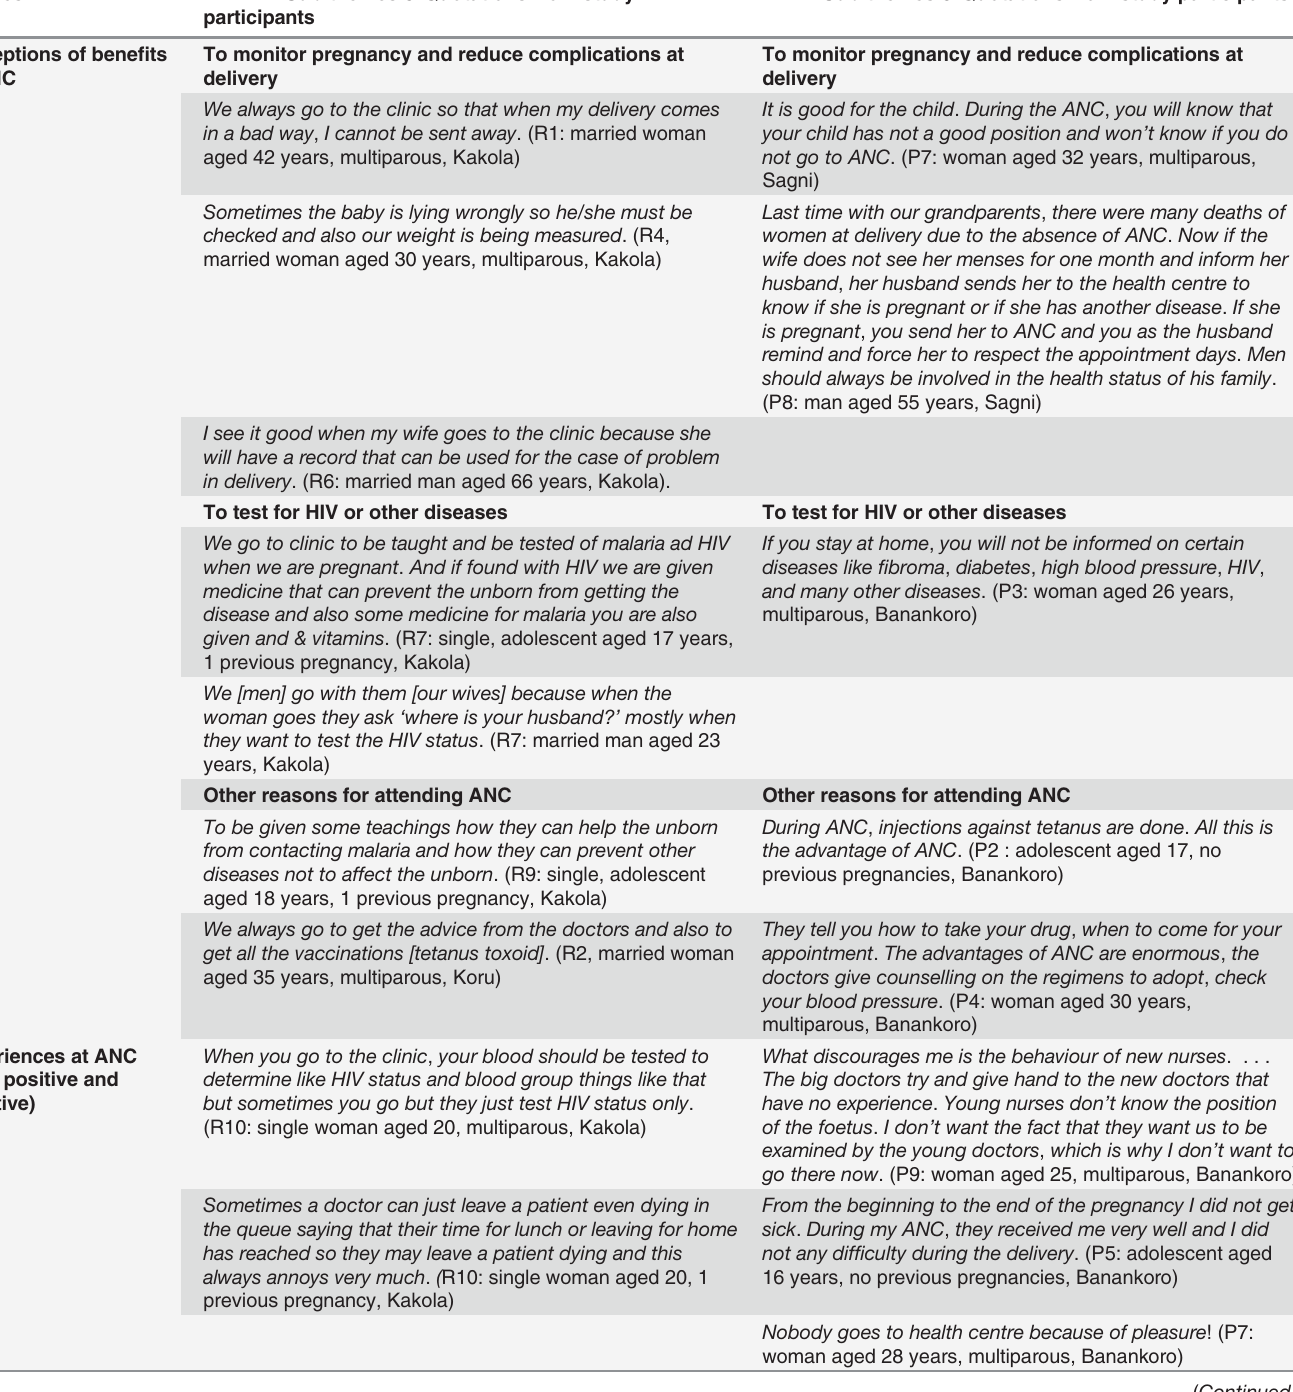
Table 2. Factors affecting pregnant women ’ s access and use of ANC.